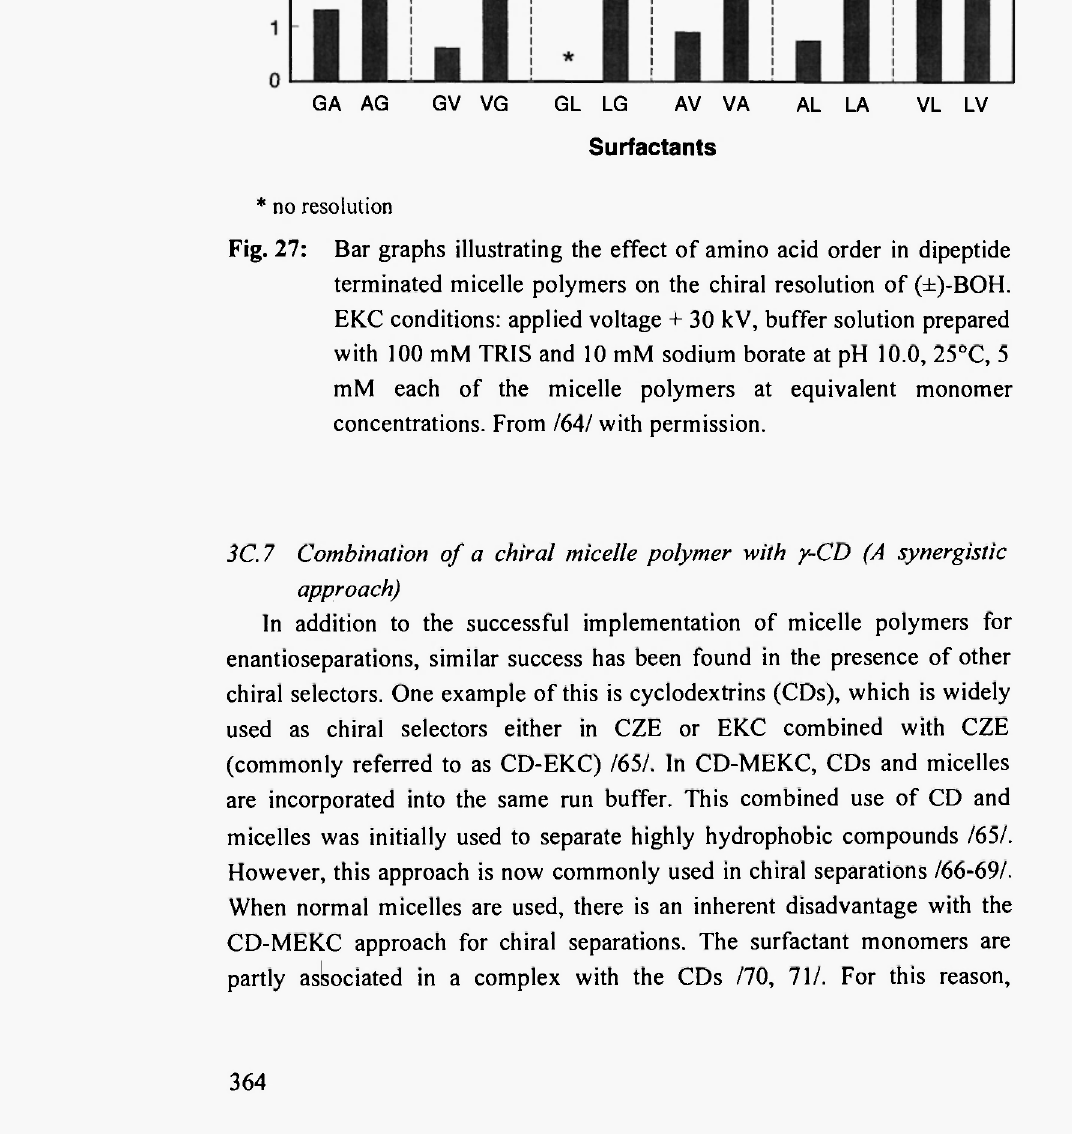
Fig. 27: Bar graphs illustrating the effect of amino acid order in dipeptide terminated micelle polymers on the chiral resolution of (±)-BOH. EKC conditions: applied voltage + 30 kV, buffer solution prepared with 100 mM TRIS and 10 mM sodium borate at pH 10.0, 25°C, 5 mM each of the micelle polymers at equivalent monomer concentrations. From /64/ with